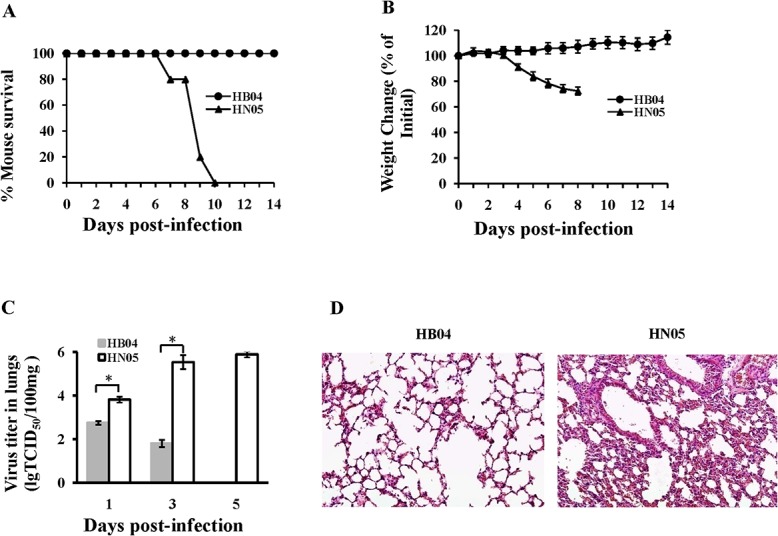
Pathogenicity of wt HB04 and HN05 viruses.(A) Survival rate of mice after intranasal inoculation with105 TCID50 of the HB04 (n = 5) or HN05 (n = 5) virus. Mortality was monitored daily for 14 dpi. (B) Mean ± standard deviation (SD) of the percent body weight change of groups of mice (n = 5) after inoculation. (C) Mean viral titers ± SD in mouse-lung homogenates (n = 5) at 1, 3, and 5 dpi (*, p<0.01). (D) Representative histopathological changes in H&E-stained lung tissues from mice infected with HB04 or HN05 at 5 dpi (20×).